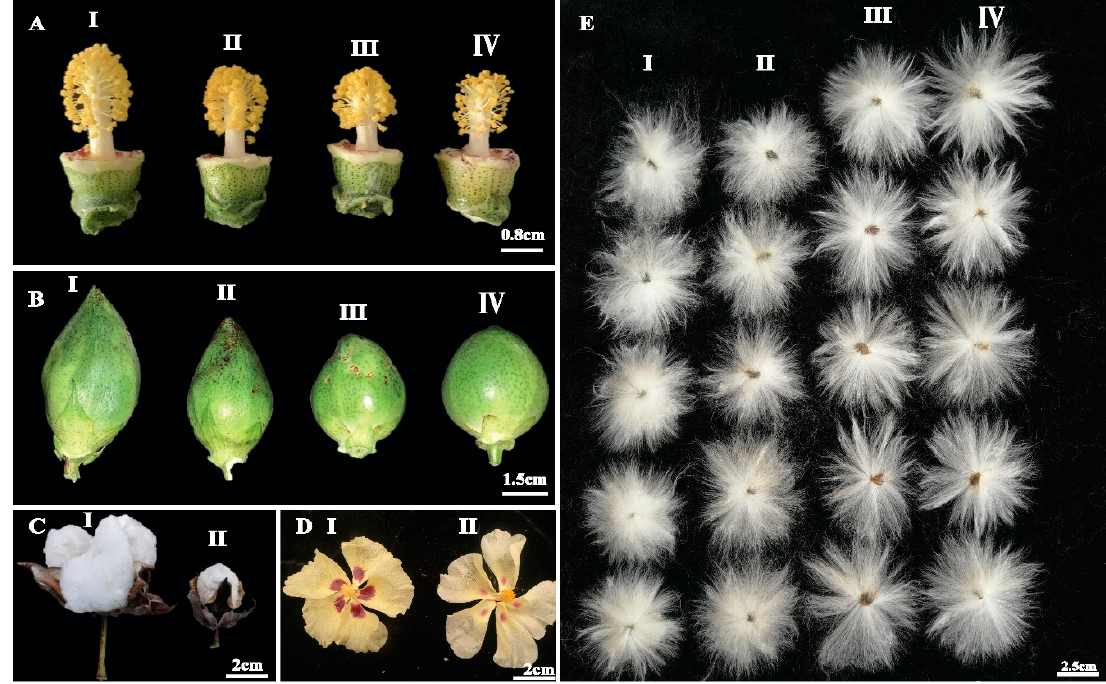
Figure 4. Phenotypic analysis of floral traits in EMS-induced mutants. ( A ) Comparison of wild type (II) and mutant lines (I, III, and IV) with varying length of flower style and anther numbers, (B ) comparison of wild type (II) with mutant lines (I, III, and IV) with different boll size and shape ranging from oblong shape to nearly round boll, ( C ) evaluation of fully mature cotton boll with big boll size in wild type (I) and small boll size in mutant line (II), ( D ) comparison of wild type (I) and mutant line (II) for size and intensity of petal spot, ( E ) comparison of fiber length with I and II as mutants with short fiber length, III represent as fiber length of wild type, IV represent mutant with longer fiber length.